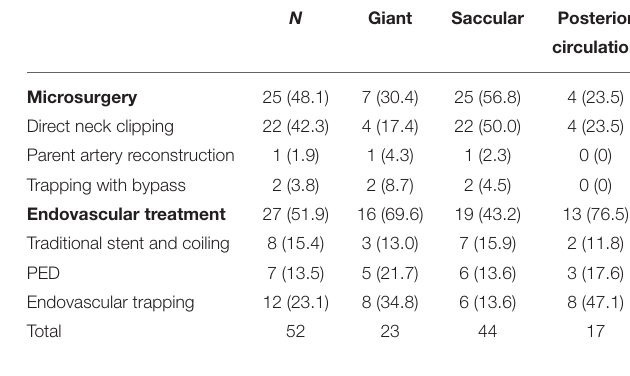
TABLE 3 | Management of paediatric